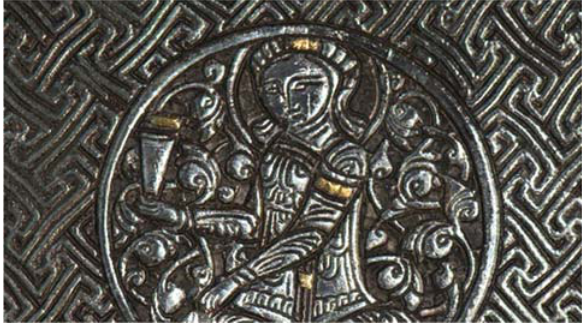
Figure 18. One frame of the HD video flyover, showing the simulated appearance of the roundel with a virtual light source from a low angle in the